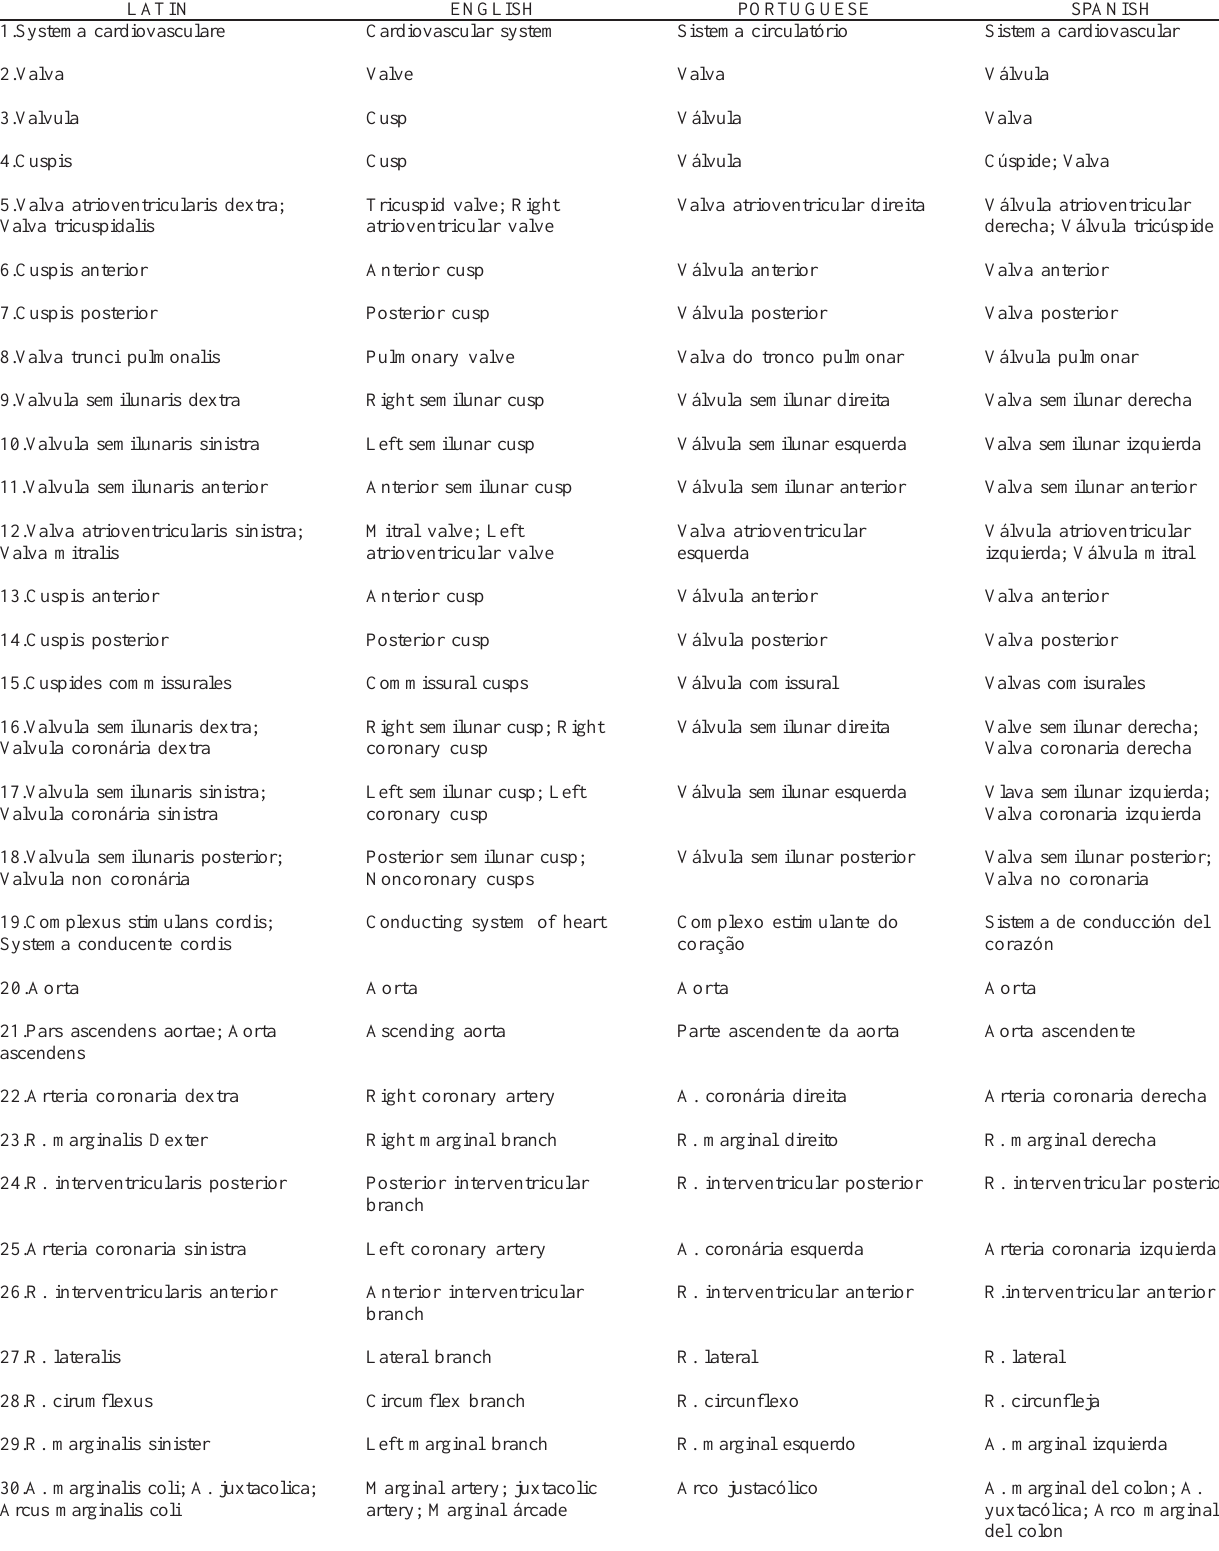
Table 1. Main used official Cardiological Terms in Latin, English, Portuguese and Spanish. LATIN 1.Systema